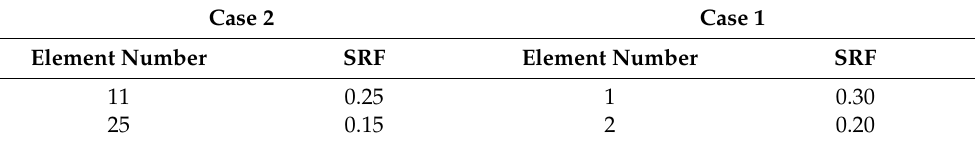
Table 3. PoDEs and DMIs of case 1 for the 31-bar planar